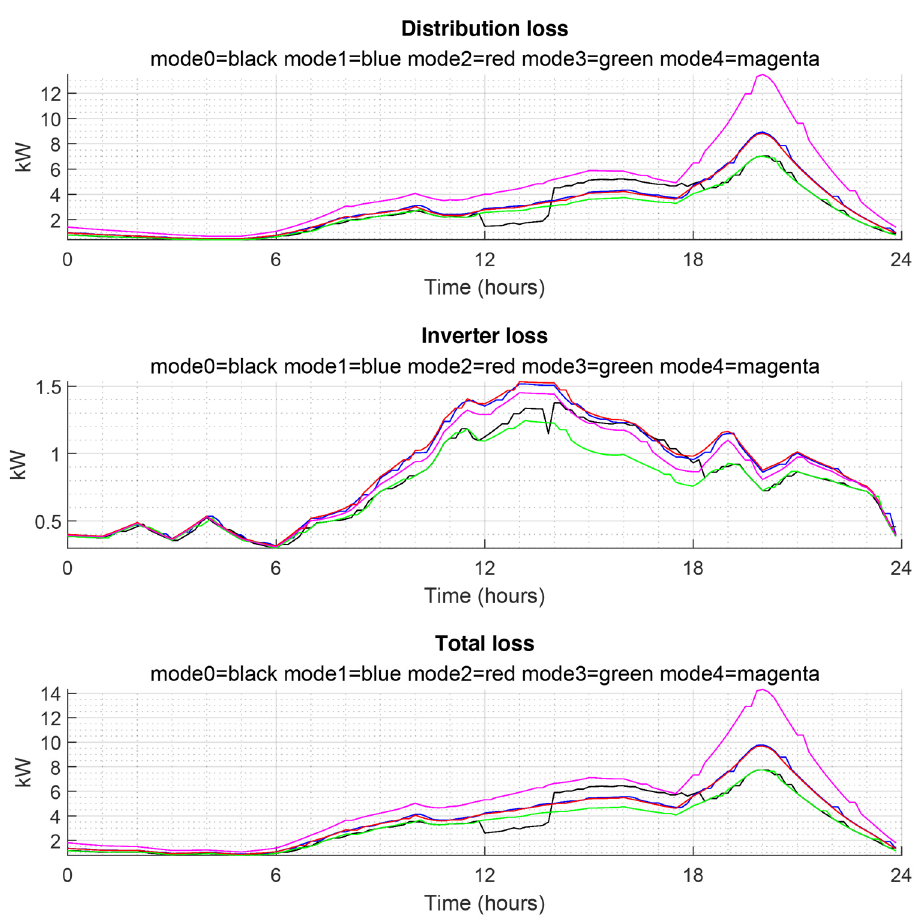
Figure 8. Loss analysis reporting, from top to bottom, distribution loss, inverters loss, and total loss.